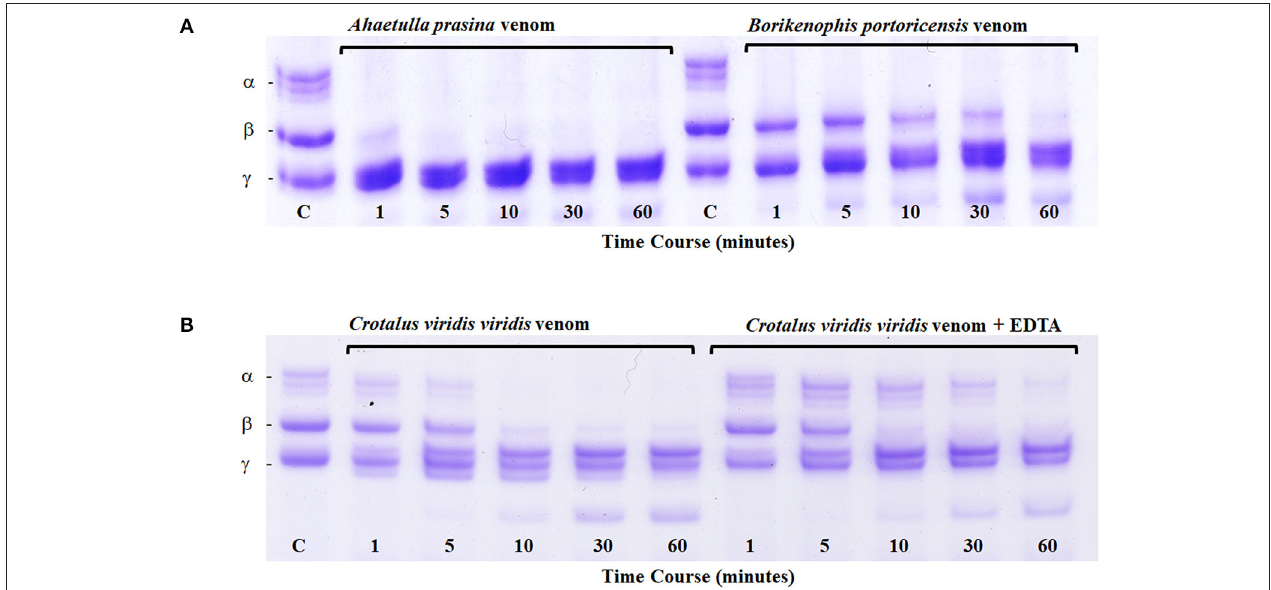
FIGURE 4 | Fibrinogen digest assay. Ahaetulla prasina and Borikenophis portoricensis crude venoms (20 µ g) were incubated with human fibrinogen over a 60-min time course (A) . The control, labeled C, was removed before the addition of any venom and shows all intact fibrinogen subunits. Fibrinogen subunits are labeled α , β , and γ . Crotalus viridis viridis crude venom incubations with and without EDTA demonstrate the effects of active and inhibited metalloproteinase activity, respectively (B) . From Modahl et al. (2018a) used with permission of